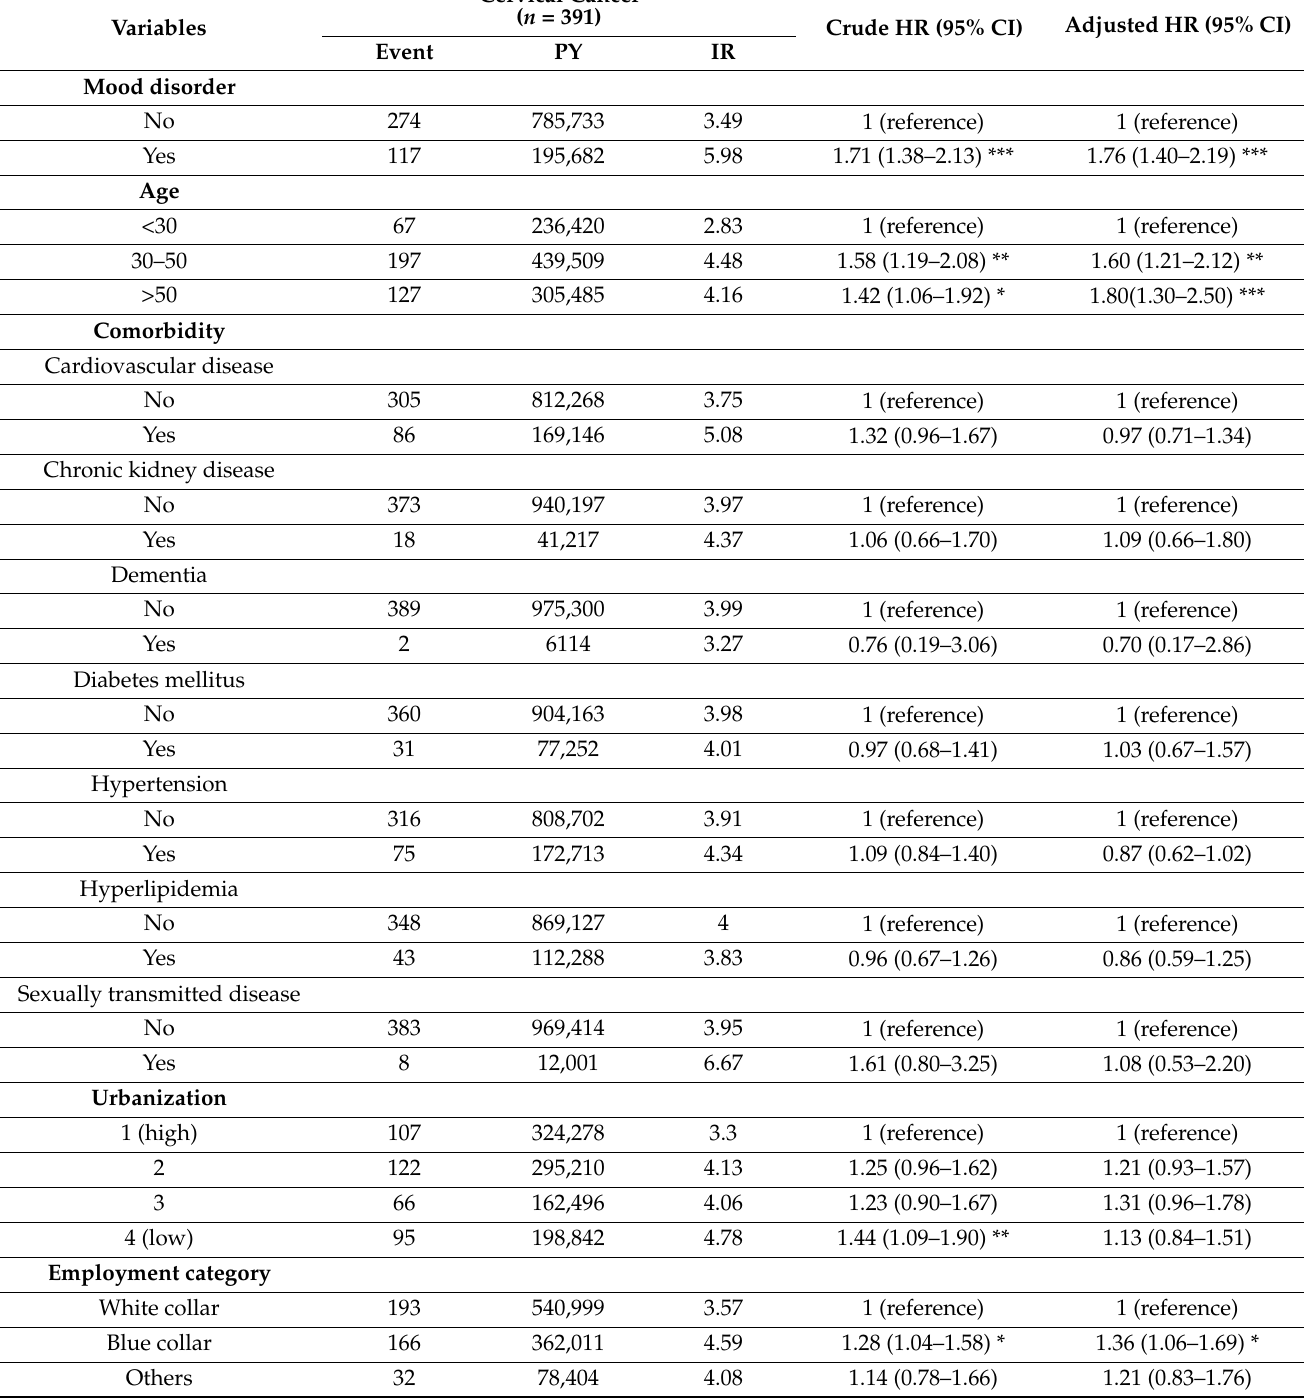
Table 2. Cox proportional hazard regression model measured hazard ratios and 95% CI of cervical cancer diagnosis associated with mood disorders and other